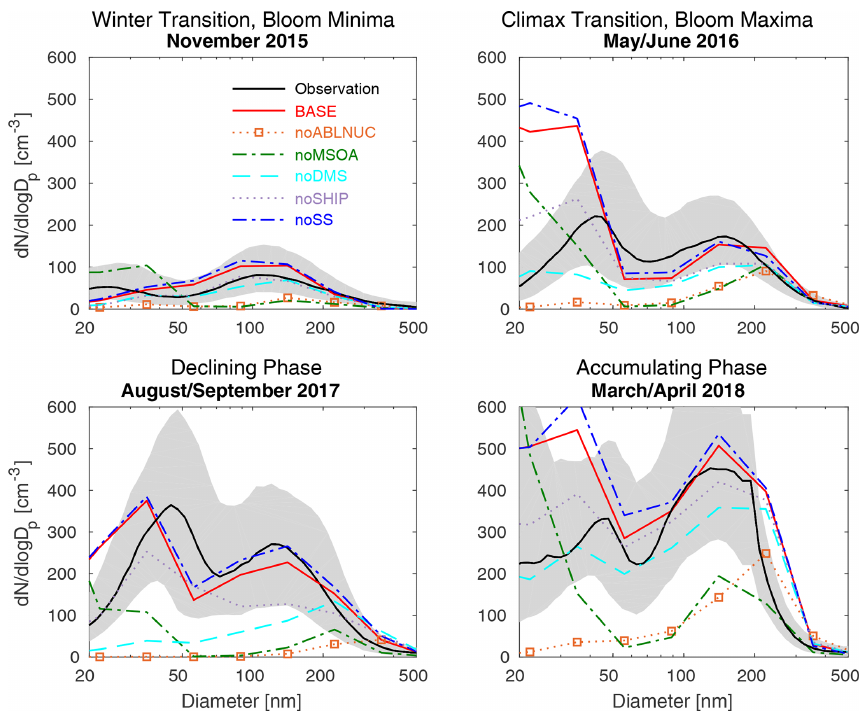
Figure 2. NAAMES cruise-track campaign-median marine-boundary-layer aerosol size distributions from marine-influenced SEMS (particle diameters 20–500nm) observations (black, with 25th to 75th percentiles in grey) and for the six GEOS-Chem-TOMAS simulations as described in Table 1 (color-coded as shown in the